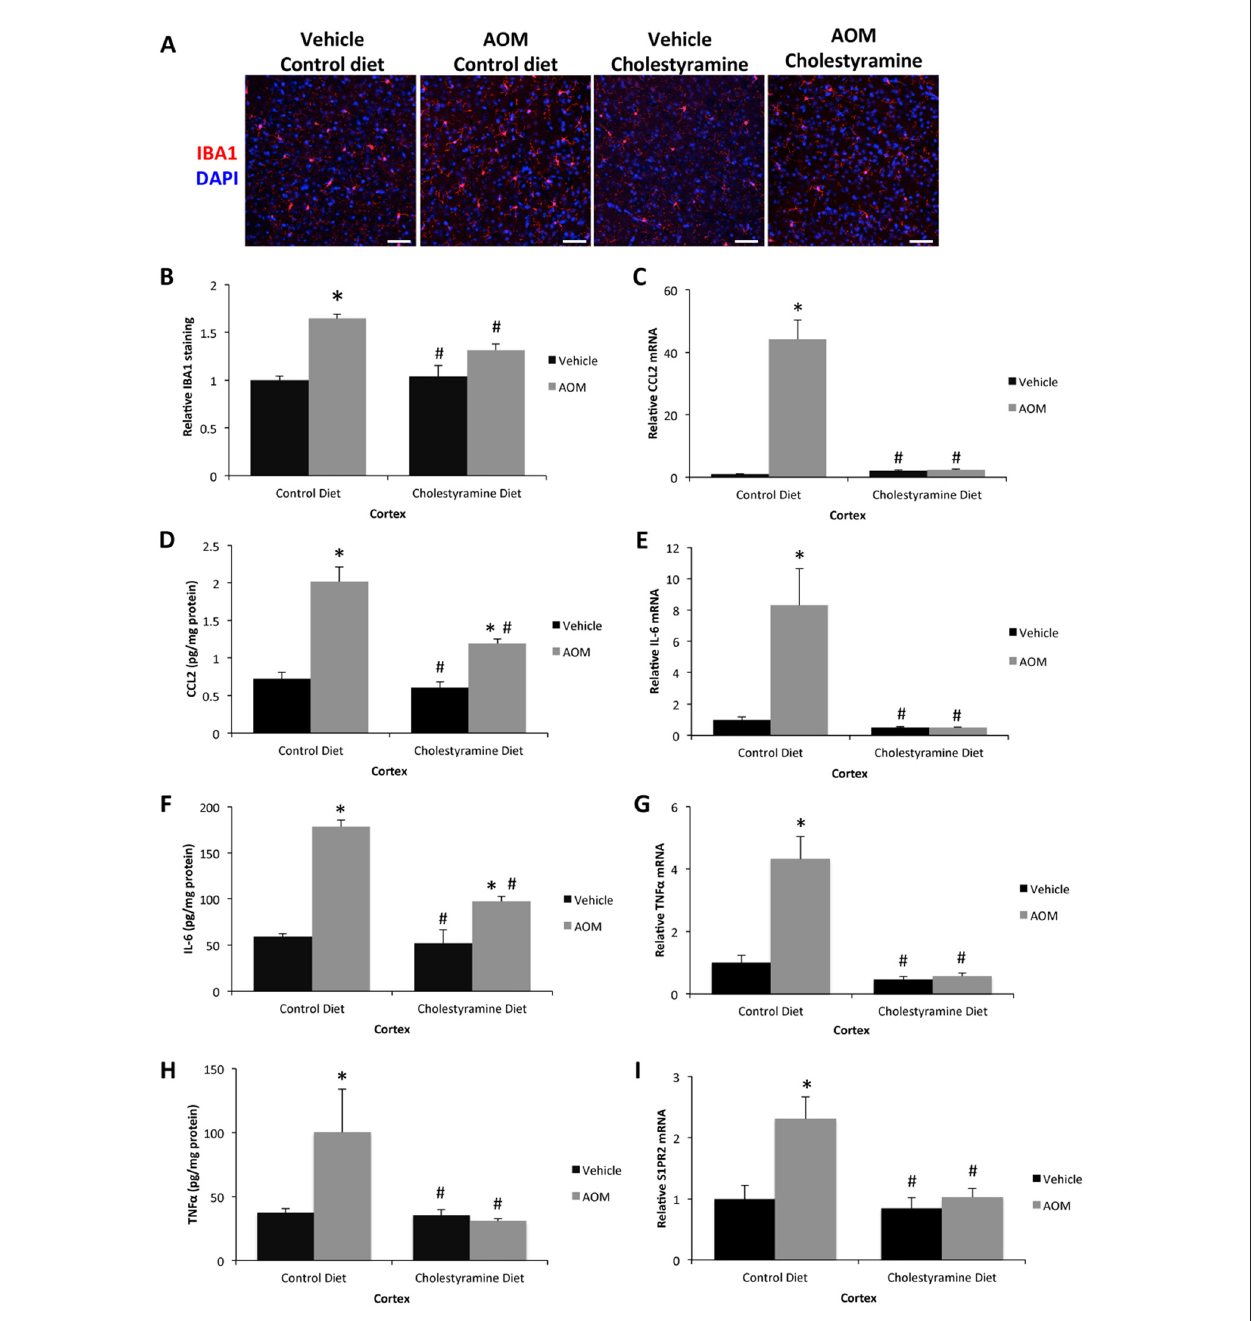
FIGURE 3 | Neuroinflammation can be reduced by cholestyramine supplementation. (A) Representative staining for IBA1 (red) in the cortex from control diet and cholestyramine diet-fed mice administered saline (vehicle) or AOM. 4 (cid:48) ,6-diamidino-2-phenylindole (DAPI; blue) was used to stain nuclei. The scale bar on the figure represents 50 µ m. (B) Quantification of relative IBA1 field staining in the cortex from control diet and cholestyramine diet-fed mice administered vehicle or AOM. (C) Relative CCL2 mRNA expression in the cortex of control diet and cholestyramine diet-fed mice administered vehicle or AOM. (D) CCL2 concentrations in cortex homogenates normalized to total protein concentrations from control diet and cholestyramine diet-fed mice administered vehicle or AOM. (E) Relative IL-6 mRNA expression in the cortex of control diet and cholestyramine diet-fed mice administered vehicle or AOM. (F) IL-6 concentrations in cortex homogenates normalized to total protein concentrations from control diet and cholestyramine diet-fed mice administered vehicle or AOM. (G) Relative TNF α mRNA expression in the cortex of control diet and cholestyramine diet-fed mice administered vehicle or AOM. (H) TNF α concentrations in cortex homogenates normalized to total protein concentrations from control diet and cholestyramine diet-fed mice administered vehicle or AOM. (I) Relative cortex sphingosine-1-phosphate receptor 2 (S1PR2) mRNA expression in control diet and cholestyramine diet-fed mice administered vehicle or AOM. ∗ p < 0.05 compared to control diet vehicle-treated mice, # p < 0.05 compared to control diet AOM-treated mice. n = 3 or greater for all analyses.